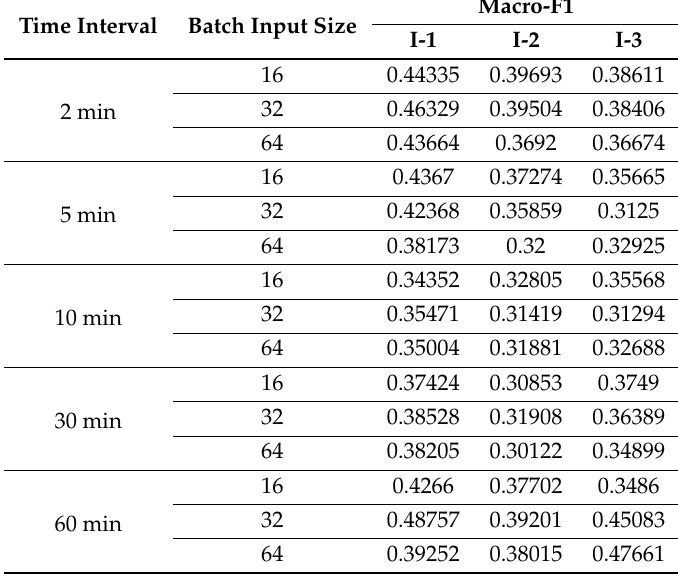
Mean macro averaged F1 testing results of all events that are obtained using leave-one-event-out cross-validation along T by varying batch input